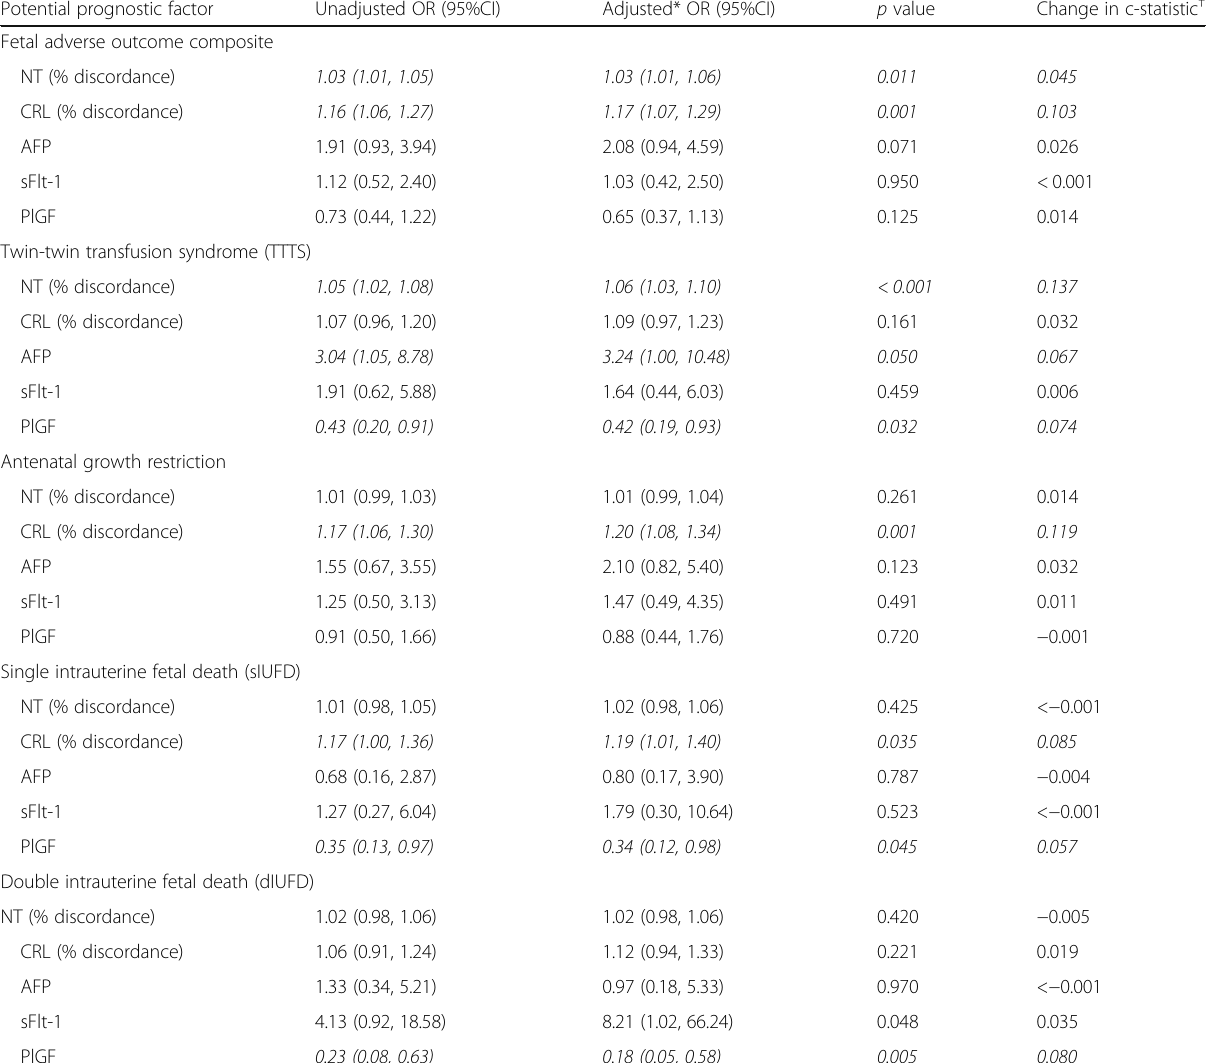
Table 3 Association between potential prognostic factors and outcome ( n = 177 pregnancies) Potential prognostic